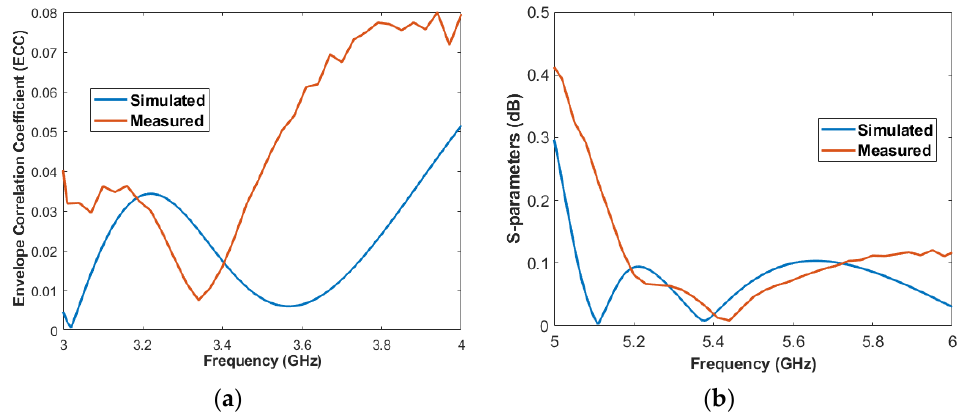
Figure 15. Measured ECC results for the ( a ) first and ( b ) second operating bands.